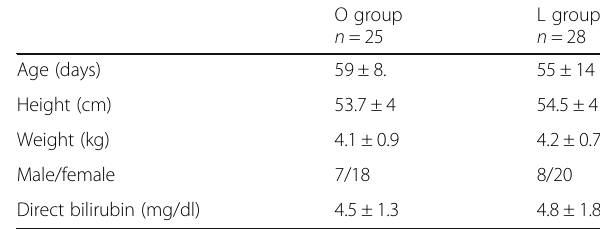
Table 1 Characteristics of